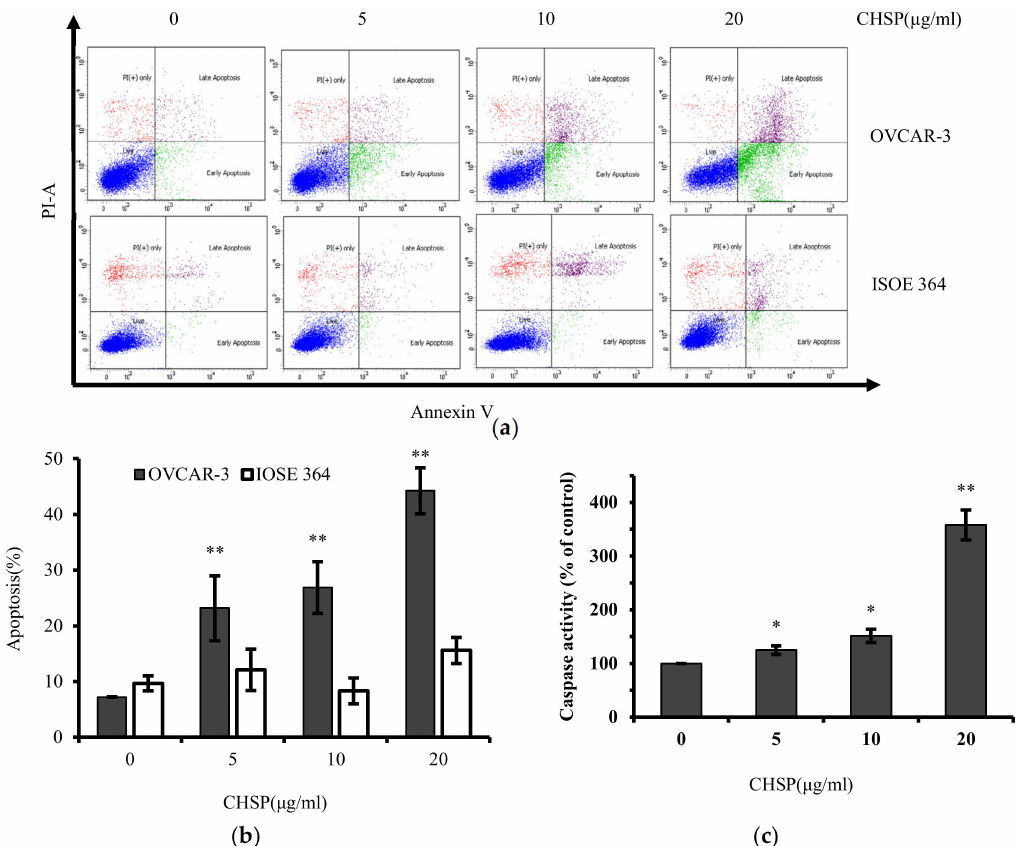
Figure 2. CHSP induced apoptosis in ovarian cancer cells (OVCAR-3) and normal ovarian cells (IOSE 364). ( a ) CHSP induced apoptosis was analyzed by flow cytometry. Cells treated with CHSP for 24 h were collected, stained with PI and Annexin V, and analyzed by flow cytometry. ( b ) Calculation